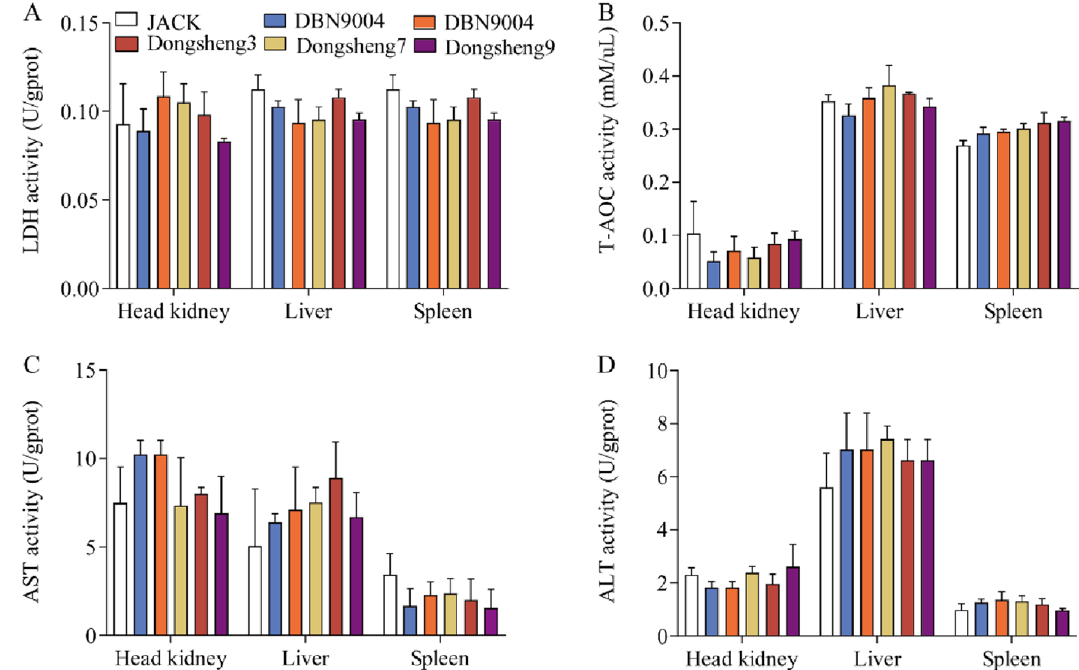
Figure 2. The enzyme activities of juvenile channel catfish fed different types of soybean diets. Head kidney, liver and spleen were collected from six groups of channel catfish at the end of the eight-week experiment, and ( A ) LDH, ( B ) T-AOC, ( C ) AST, ( D ) ALT were measured. The abscissa represents the sample type (Head kidney, Liver and Spleen) and different colors represent different sample groups. Data are presented as mean ± SE (n = 3). * p < 0.05 versus JACK ( t